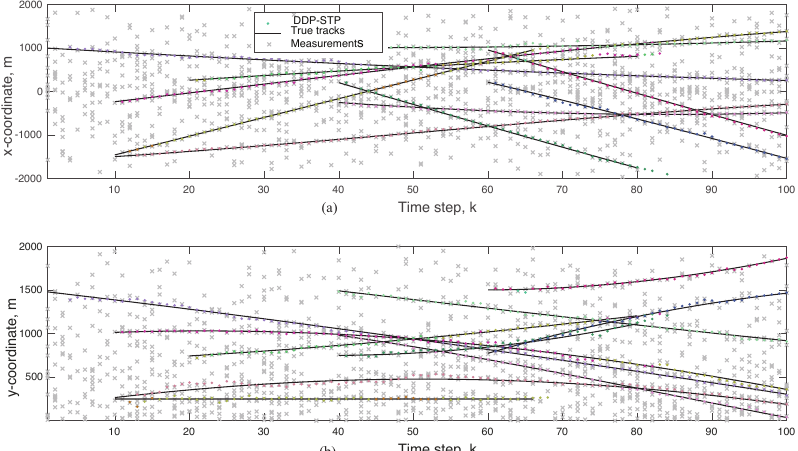
Figure 3. ( a ) x k and ( b ) y k actual and DDP-STP estimated coordinates at time step k in Experiment 1. DDP-STP determines that the scattered measurements (marked by x ) correspond to clutter.